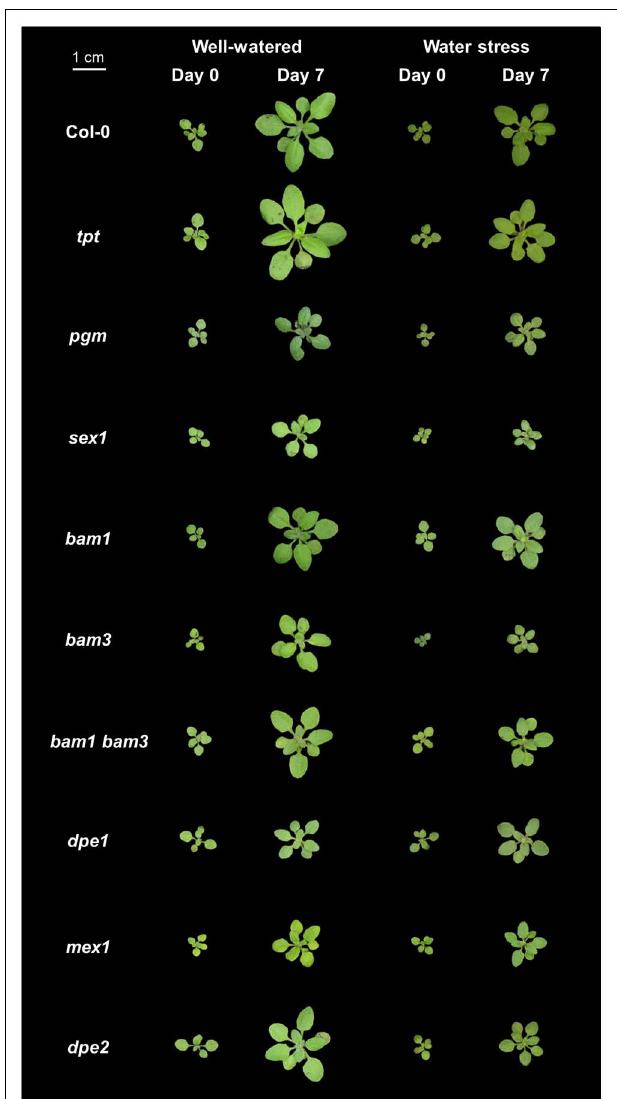
FIGURE 1 | Photographs of representative plants of Arabidopsis mutants affected in carbon metabolism grown in well-watered conditions or under soil water stress. The wild-type Col-0 is shown at day 0 and day 7 following emergence of the sixth leaf in well-watered conditions or under moderate water stress (predawn water potential of − 0.7 MPa), together with a mutant affected in the daytime translocation of chloroplastic photosynthates ( tpt ), starch metabolism ( pgm ), or starch utilization at night ( sex1 , bam1 , bam3 , bam1 bam3 , dpe1 , mex1 , dpe2 ).